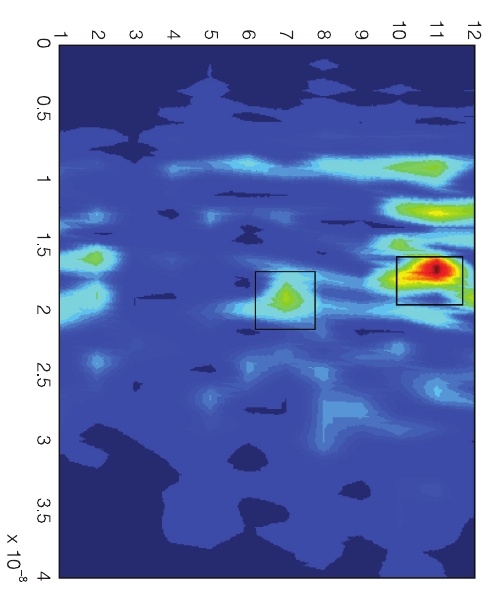
Fig. 7. Image of two parallel empty plastic pipes at 85 cm of depth in ungated mode. Linear common offset (distance between the gaps of 55 cm). Diameter of the pipes of 40 cm. Distance between the axes of the pipes of 60 cm. Frequency band of 200-800 MHz. Frequency step of 2 MHz. The abscissa is the number of scan with spatial step 20 cm. The ordinate is the return time in seconds.